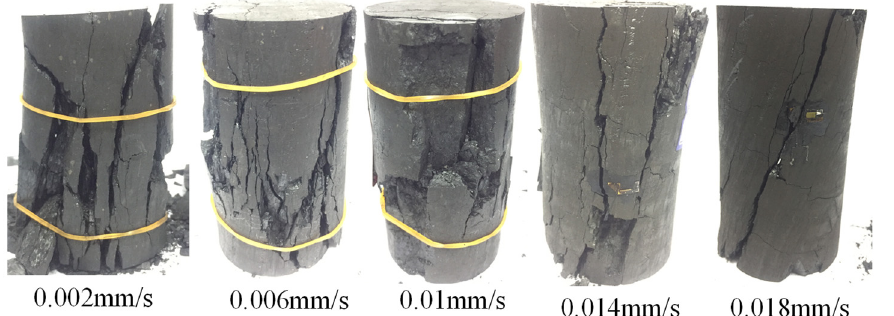
Figure 2. Final failure mode of coal sample.